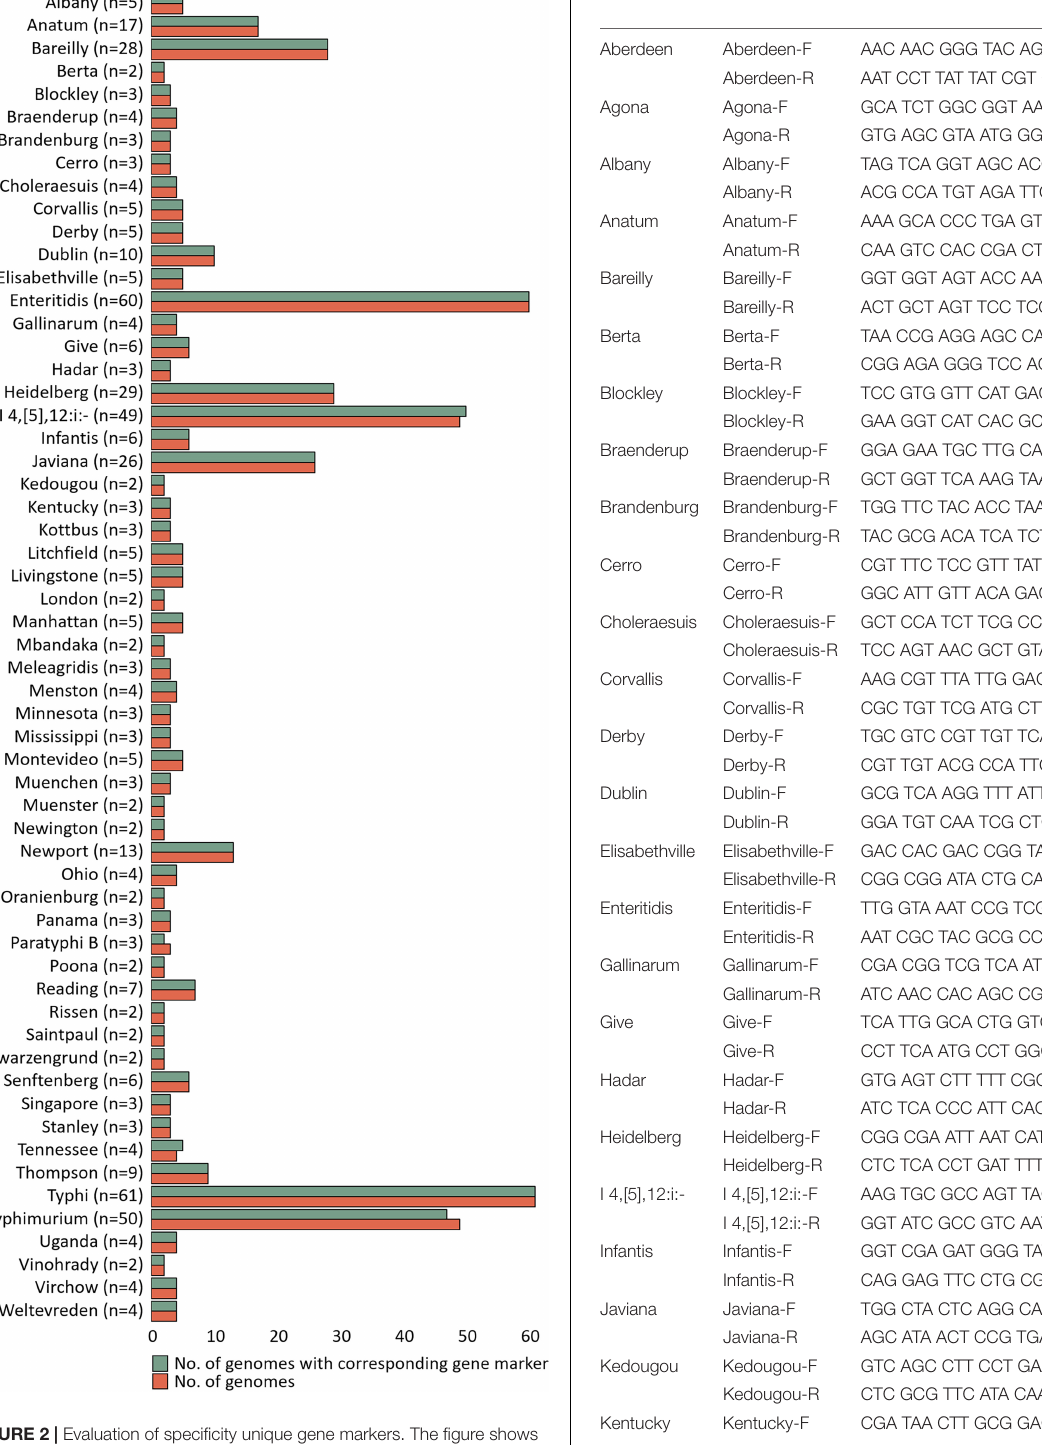
FIGURE 2 | Evaluation of specificity unique gene markers. The figure shows the presence or absence of unique gene markers in 535 genomes. The number of analyzed genomes for each serovar is shown in the green bar, and the number of genomes with gene marker corresponding to that serovar is shown in the red bar.